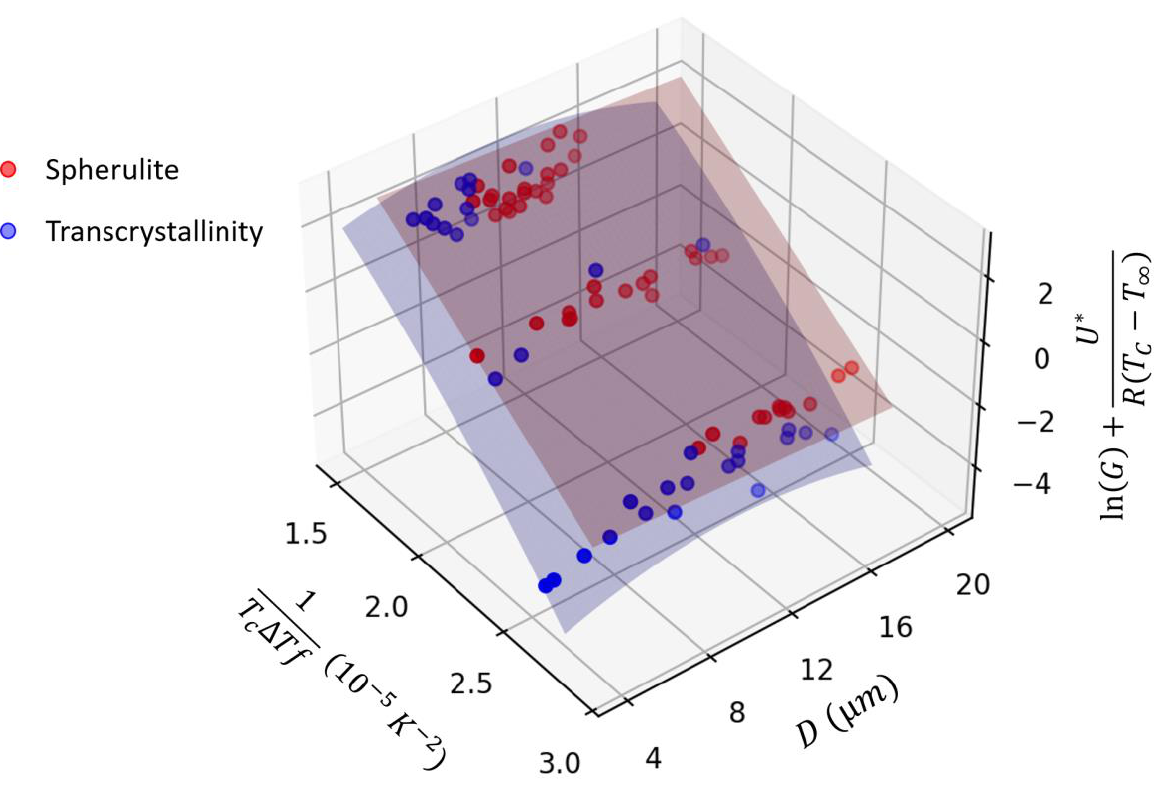
Figure 7. Fitted GPR models to spherulite and transcrystallinity growth rate data in the transformed Lauritzen-Hoffman domain (Equation (2)).